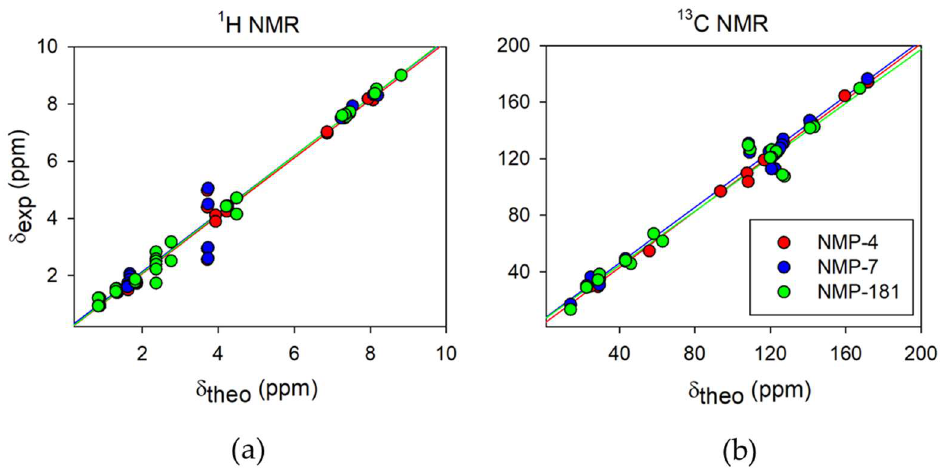
Figure 2. Correlation graphs of calculated δ values (in ppm) with the experimental δ values. In: ( a ) 1 H and ( b ) 13 C NMR for the NMP compounds obtained at BP86/cc-pVTZ level of theory in chloro- form.